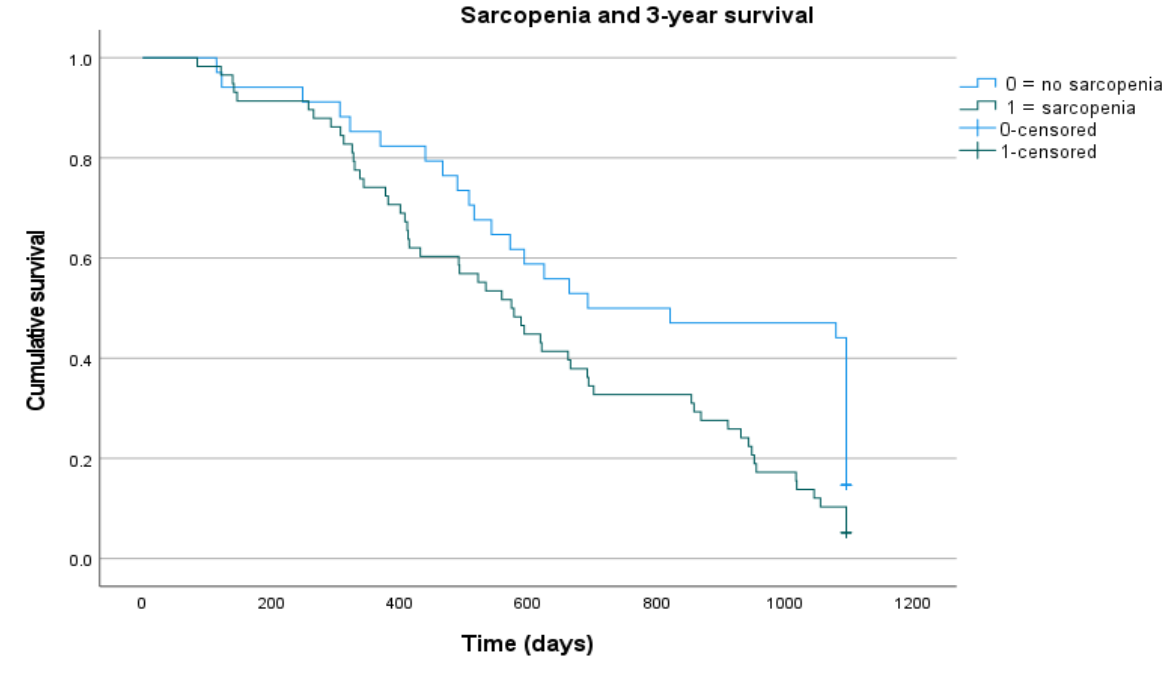
Figure 3. Kaplan-Meier curve demonstrating that over the total follow-up period of three years the AI-derived body composition parameter sarcopenia evolves as a significant imaging predictor of survival in patients with pancreatic adenocarcinoma. Patients suffering from sarcopenia had significantly poorer survival rates (log-rank, p = 0.006).